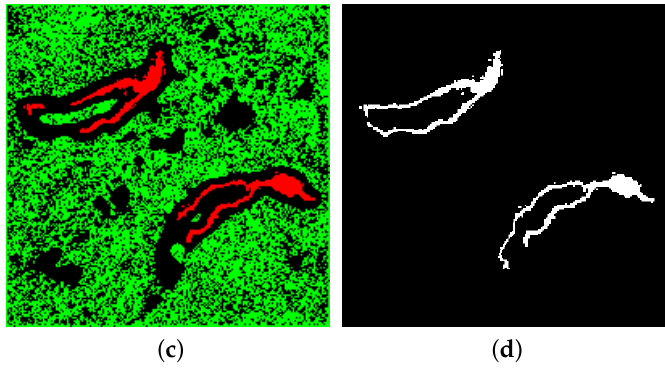
Figure 4. Example of proposed unsupervised change detection. The original multi-temporal images are retrieved from [34]. The first principle component ( b ) are selected by the algorithm described in Section 3.1, in which t = 0.8. In the pre-labeled map of selected component ( c ), pixels of change, non-change and non-labeled are represented with red, green and black. The change pixels in ( d ) are marked with white. ( a ) false color image obtained by CVA; ( b ) the component selected by proposed algorithm; ( c ) pre-labeled map of the selected component; and ( d ) change map obtained by random walks.